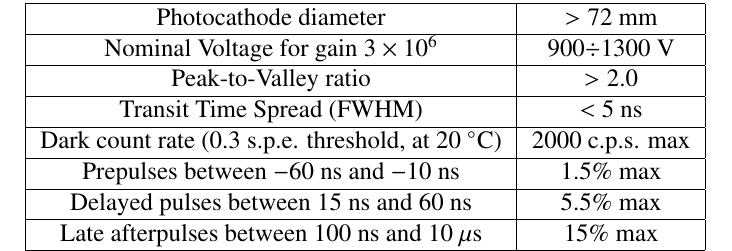
Table 1: Requirements for the main characteristics of PMTs to be used in the KM3NeT